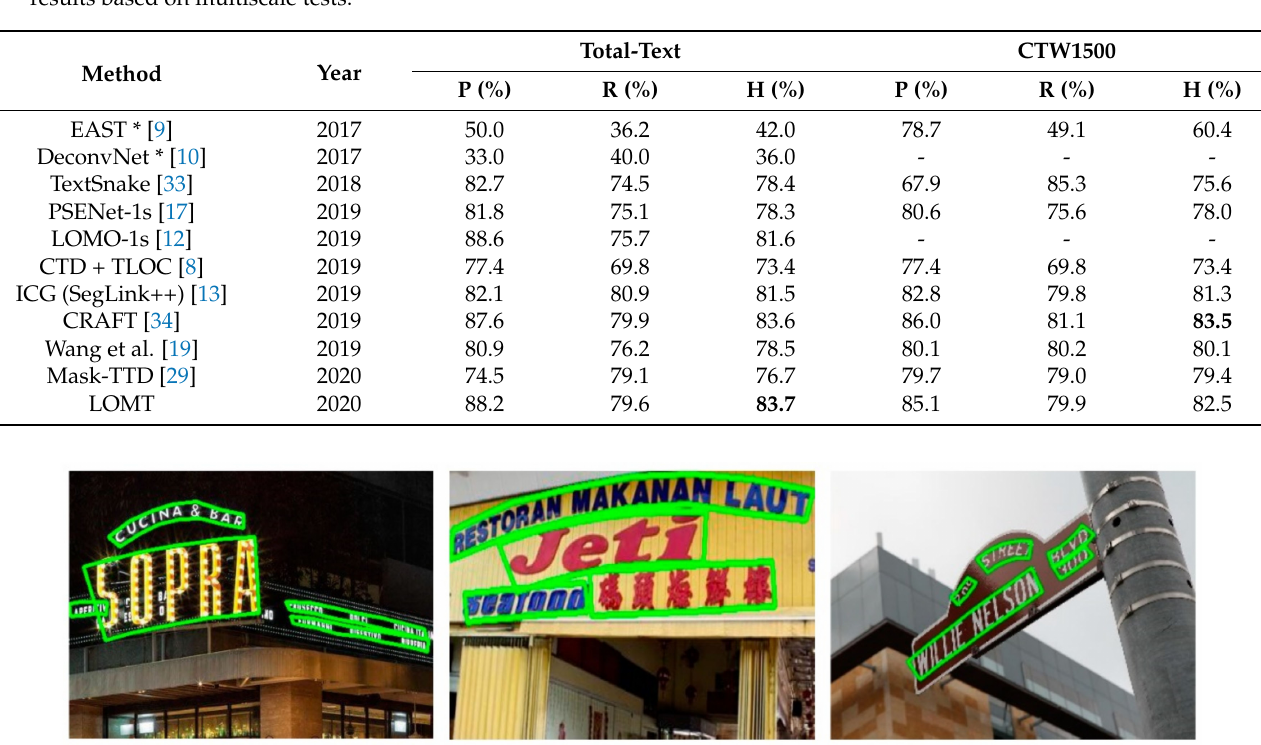
Figure 5. Some qualitative results of the proposed method on Total-Text.